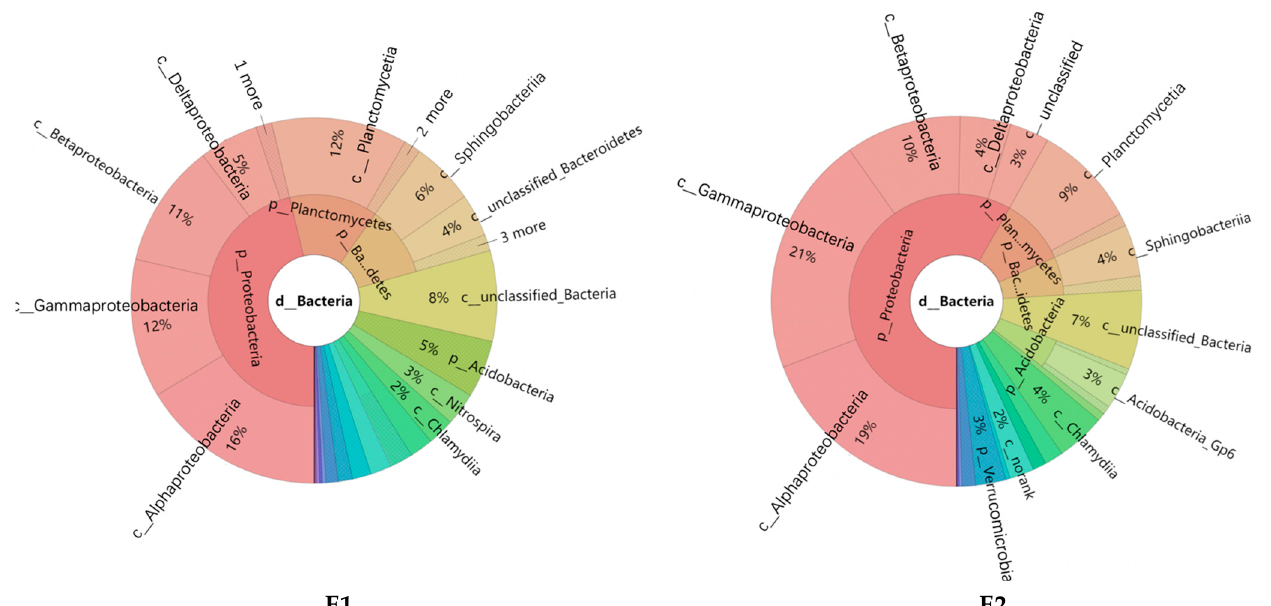
Figure 9. Microbial relative abundance on substrates at the phylum level.